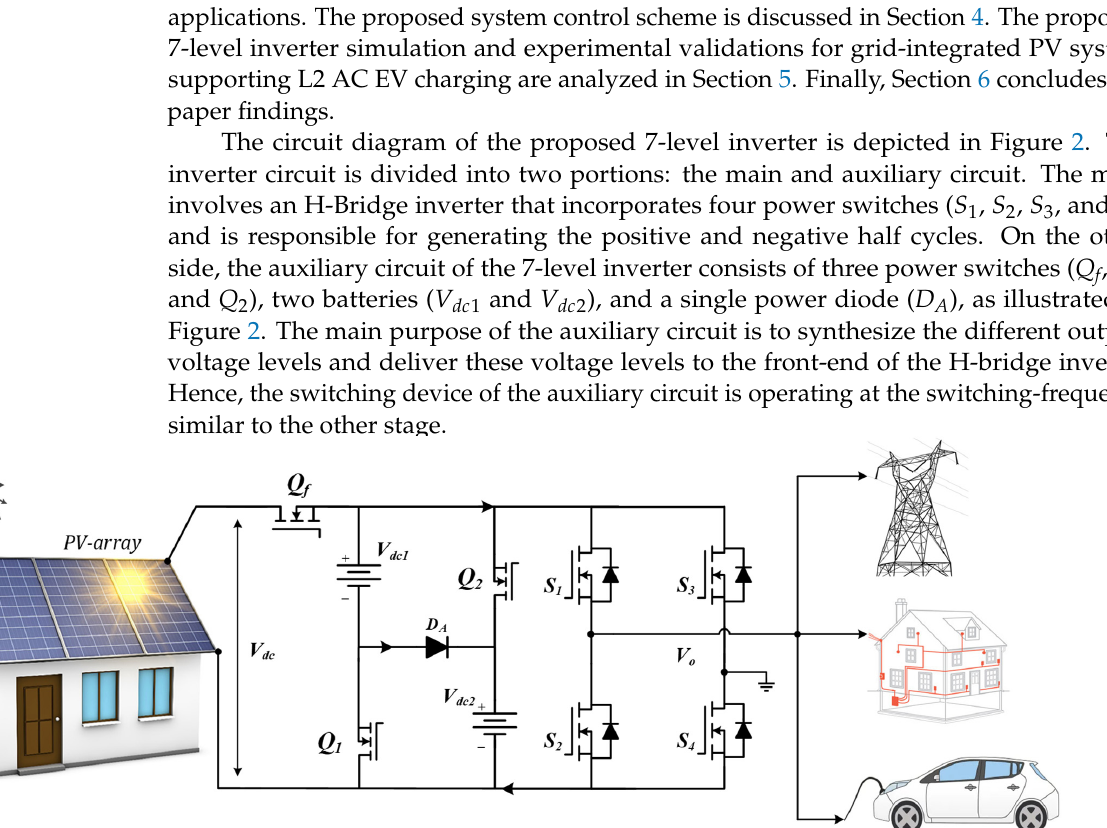
Energies 2021 , 14 , x FOR PEER REVIEW Figure 1. Circuit configuration of solar PV system integrated with the grid and EV loads via the proposed 7-level inverter.